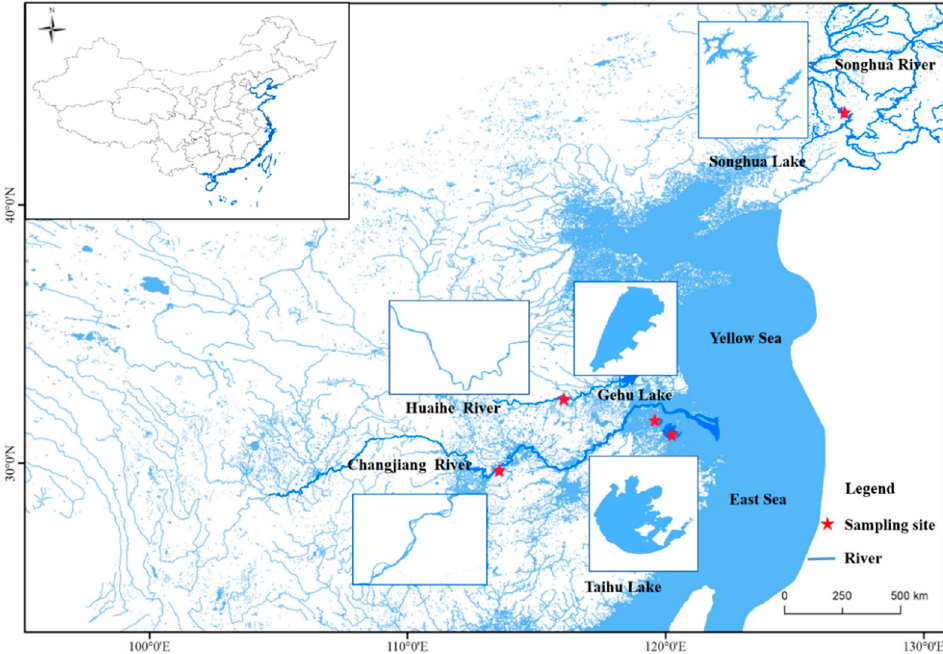
Figure 1. Sampling locations of C. alburnus in 5 different river Figure 1. S ampling locations of C. alburnus in 5 different river basins. Table 1. Sampling information of C. alburnus in five different river basins.